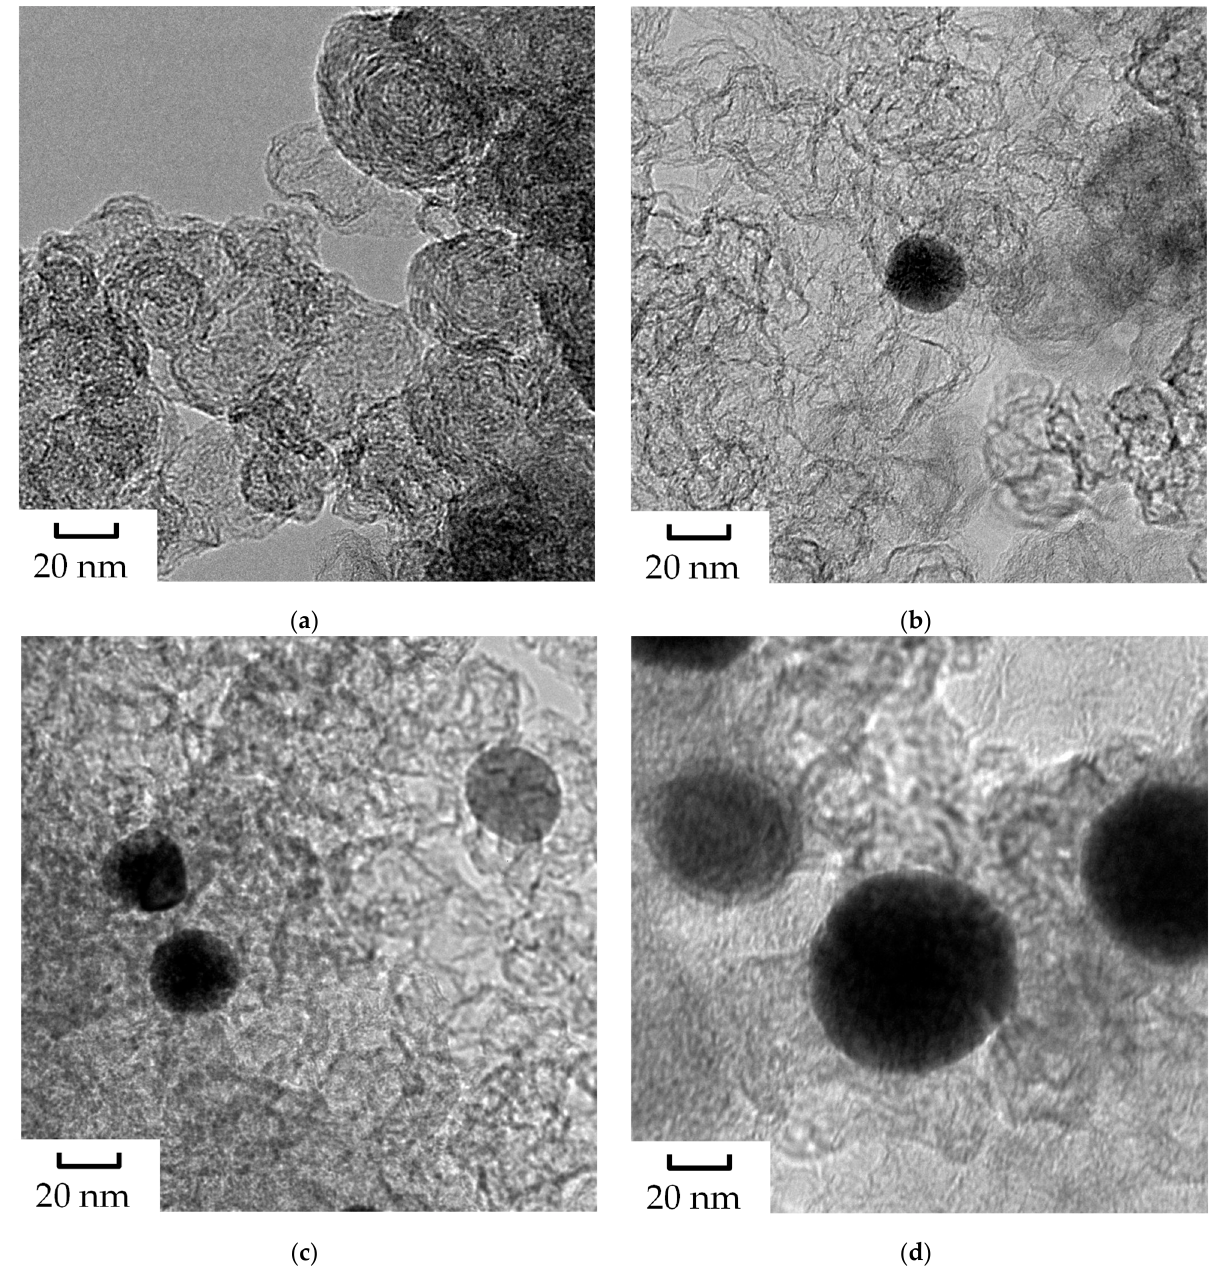
Figure 3. TEM images of ( a ) KB, ( b ) KB_0.6, ( c ) KB_4.9, and ( d ) KB_9.3.